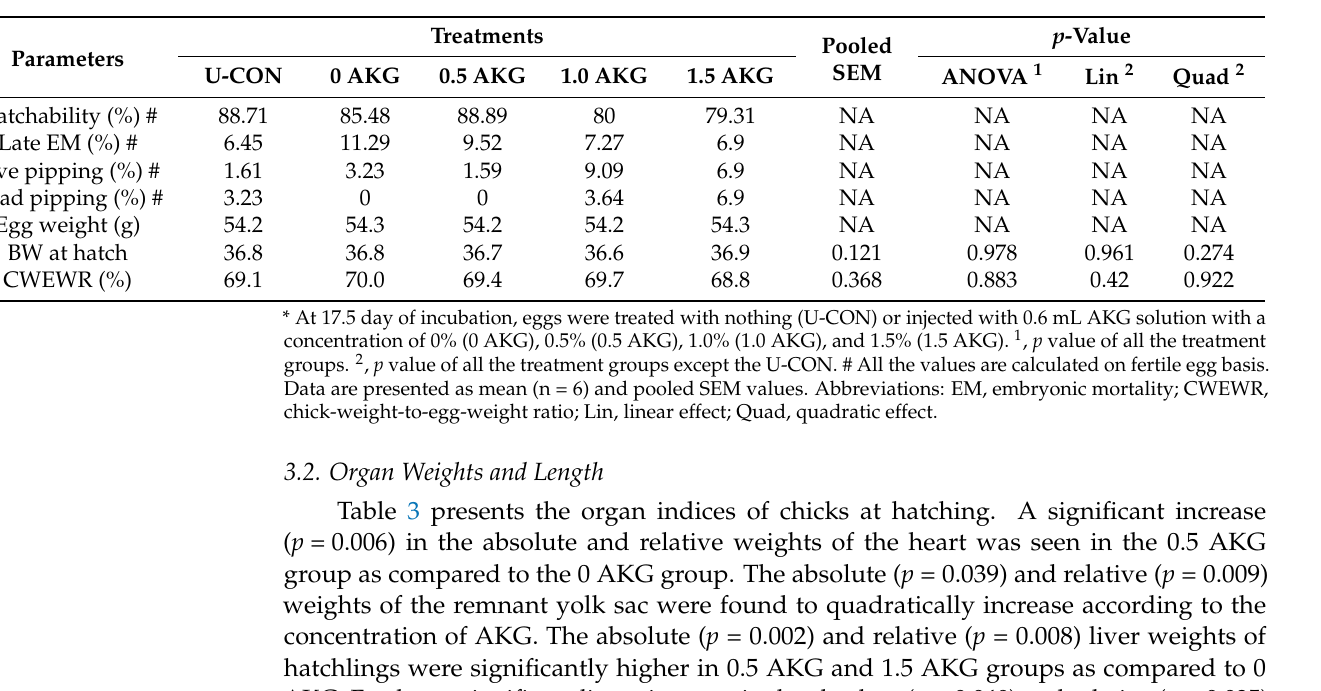
Table 2. Effects of in ovo feeding of α -ketoglutaric acid (AKG) on hatchability parameters of broilers *.